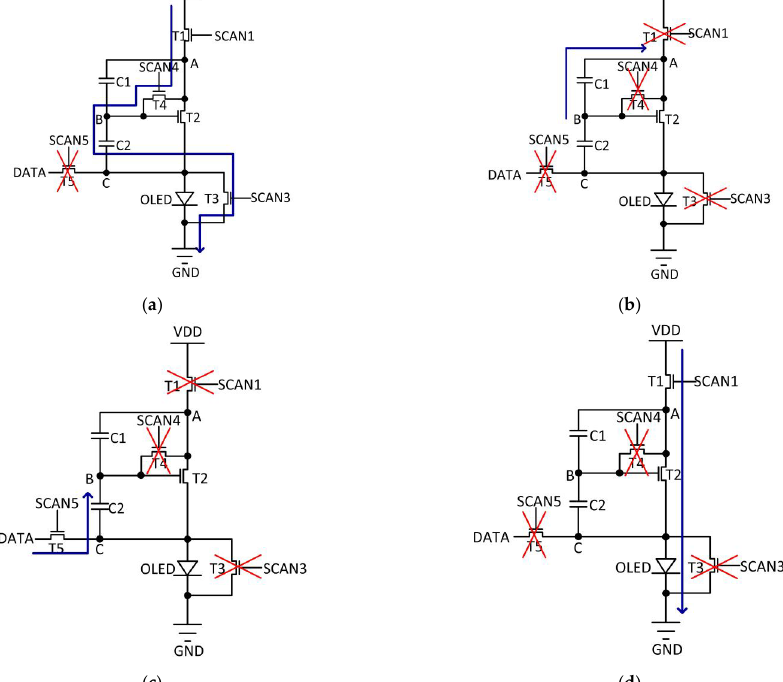
Figure 3. Schematic of the circuit operation in ( a ) initialization stage, ( b ) threshold voltage extraction stage, ( c ) data input stage, and ( d ) emission stage. Because T1 and T4 are turned on, the voltage of node B is charged to VDD. Because T3 is turned on, no current flows through the OLED. Therefore, the OLED flicker is prevented.